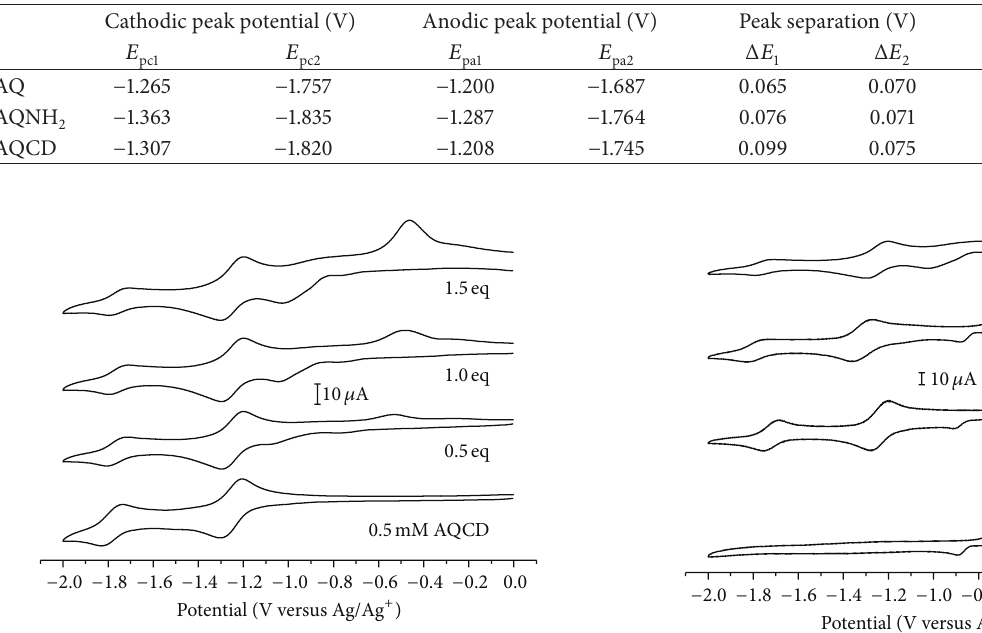
for the redox peaks for AQCD, AQNH 1/2